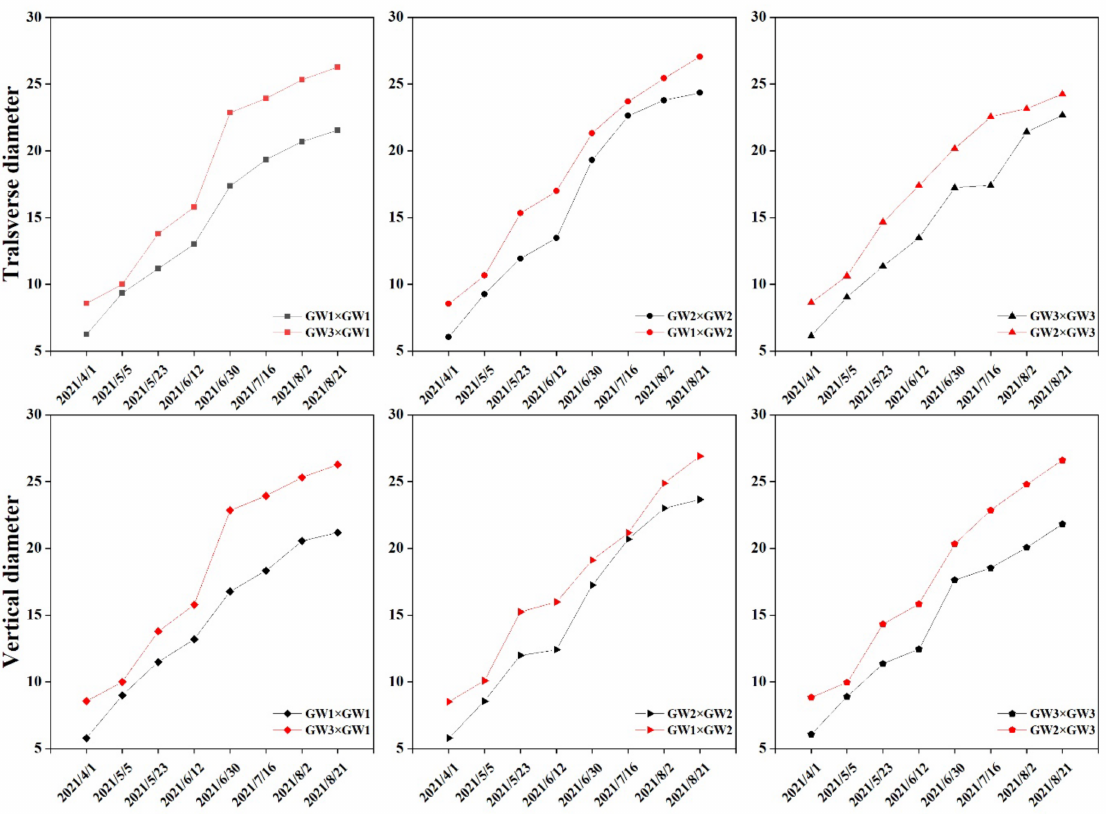
Figure 7. Change patterns of the transverse and horizontal diameters of the fruits of the selfed and crossed